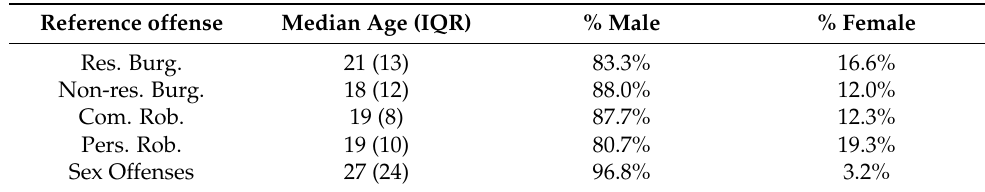
Table 2. Offender demographic